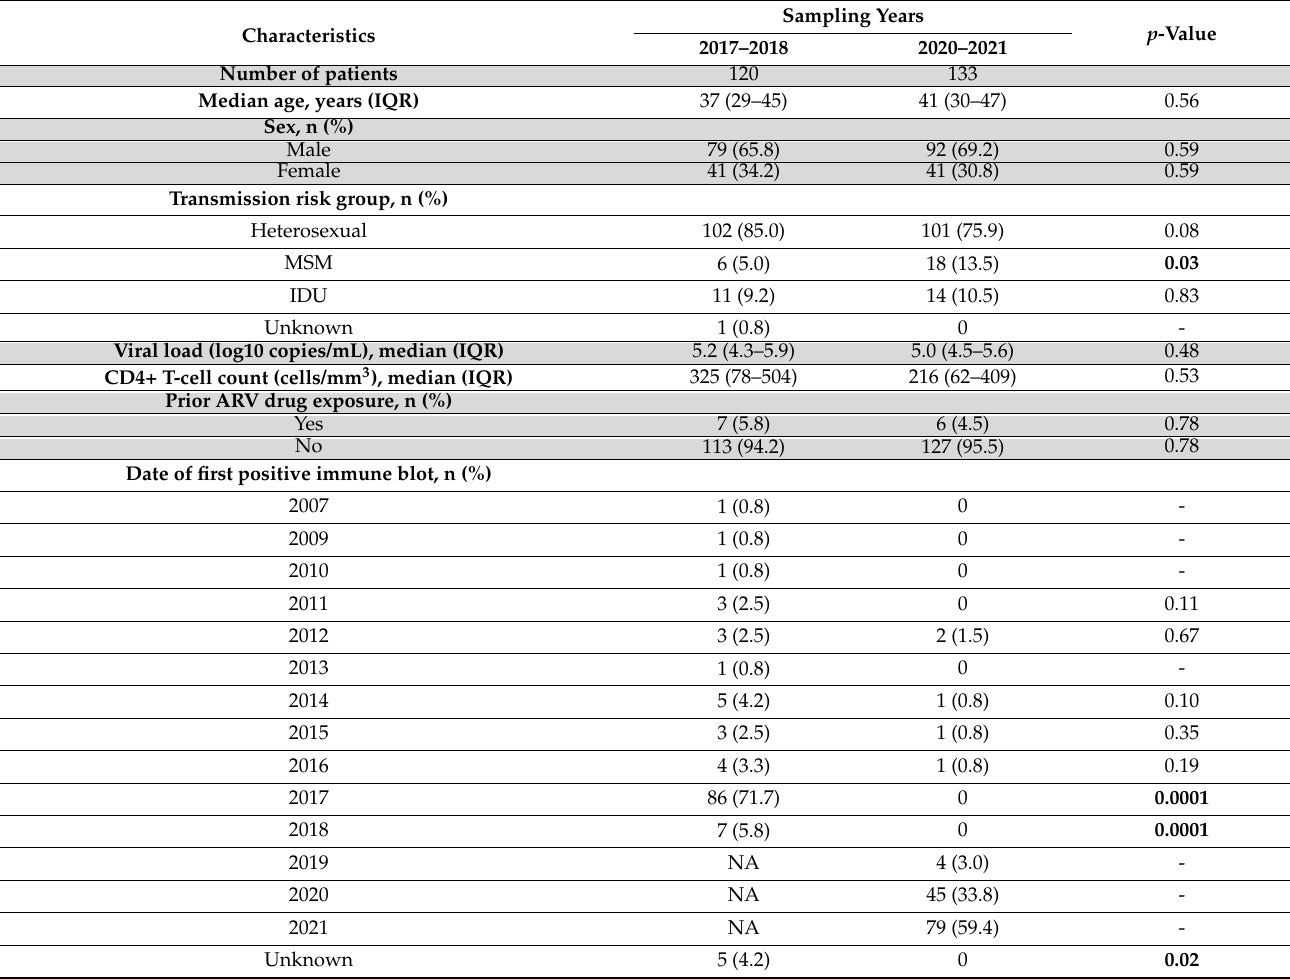
Table 1. Epidemiological and clinical characteristics of the study